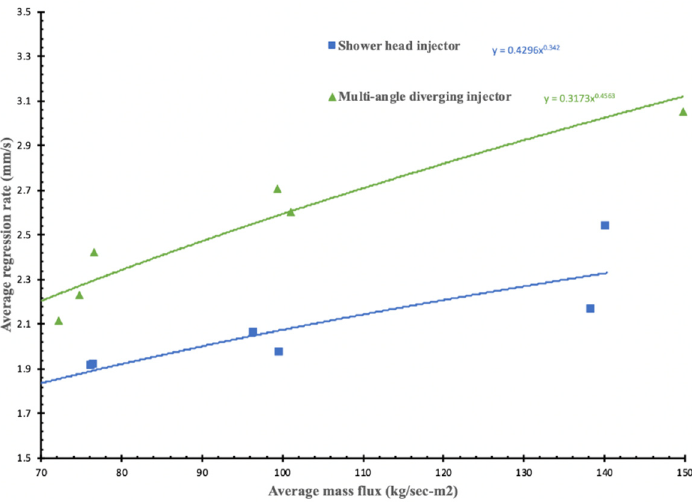
Figure 10. Average regression rate vs. average mass flux using the two different injector designs for paraffin wax fuel.